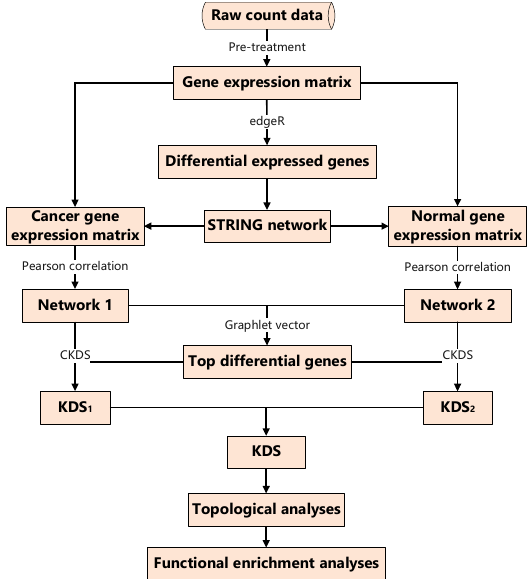
Figure 1. The overall framework for criterion to explore the kernel differential subgraph (CKDS). KDS: kernel differential subgraph.